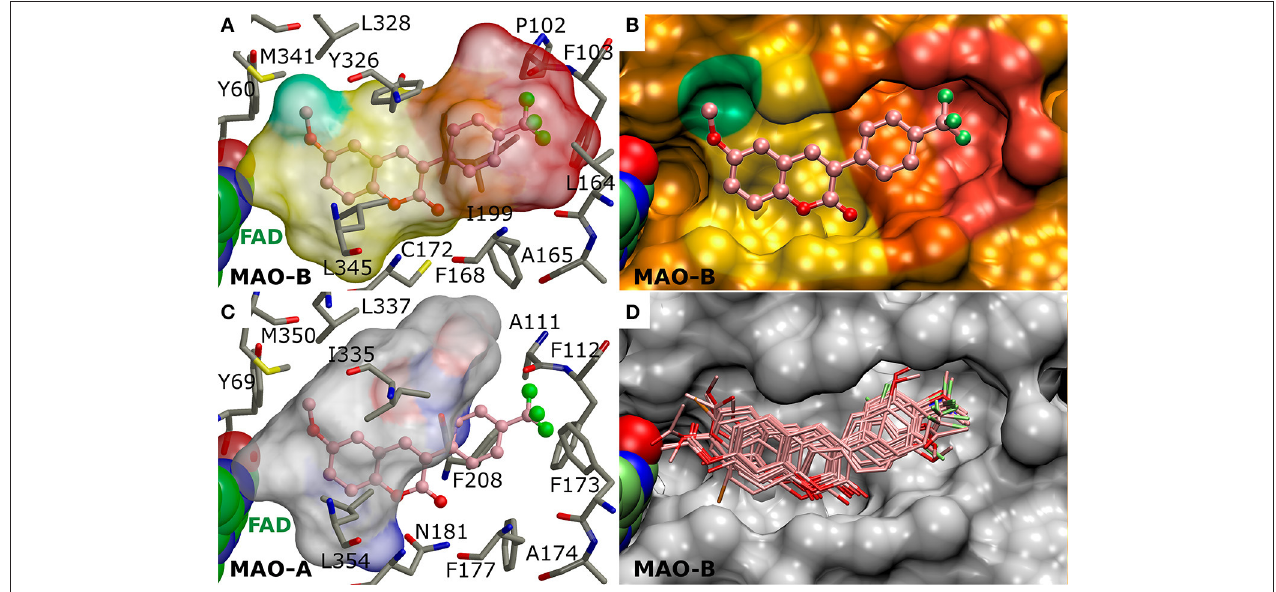
FIGURE 3 | The active site of monoamine oxidase B with docked 3-phenylcoumarin derivatives. (A) A negative image of the MAO-B active site shown as a transparent surface indicates the space available for inhibitor binding with docked derivative 1 (ball-and-stick model; Figure 2 ). (B) A cross section, showing half of the active site, displays the contours (opaque surface) that roughly match the inhibitor shape and conformation. The colored sectors highlight specific sections of the cavity dedicated to different aspects of the 3-phenylcoumarin derivative binding: 3-phenyl ring (orange), the R4-R7 groups of the 3-phenyl ring (red), coumarin ring (yellow), the hydrophobic niche occupied by the R1/R2-groups of the coumarin ring (green). (C) A negative image of the MAO-A active site shows that only two residue changes (Ile199 → Phe208; Leu164 → Phe173) are enough to prevent 3-phenylcoumarin analog binding. (D) The docked poses of the 23 most potent 3-phenylcoumarin derivatives show what space is collectively occupied by the new inhibitors. See Figure 1 for